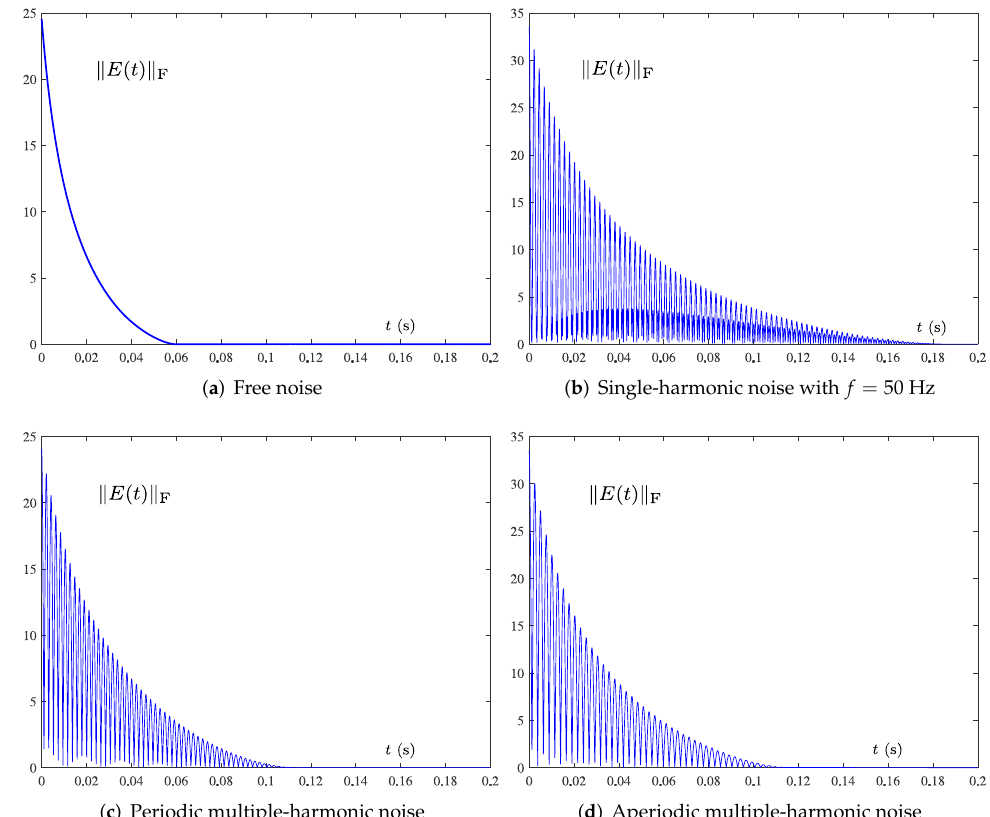
Figure 12. Dynamic characteristics of PTCAZNN (15) for high-dimensional matrix inversion under various